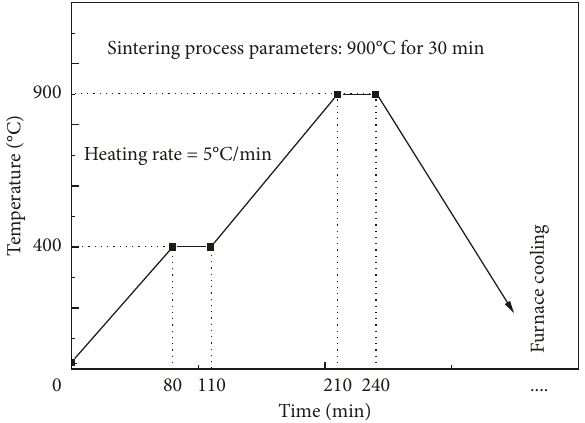
Figure 1: Parameters of the sintering process for the PCFSSs.